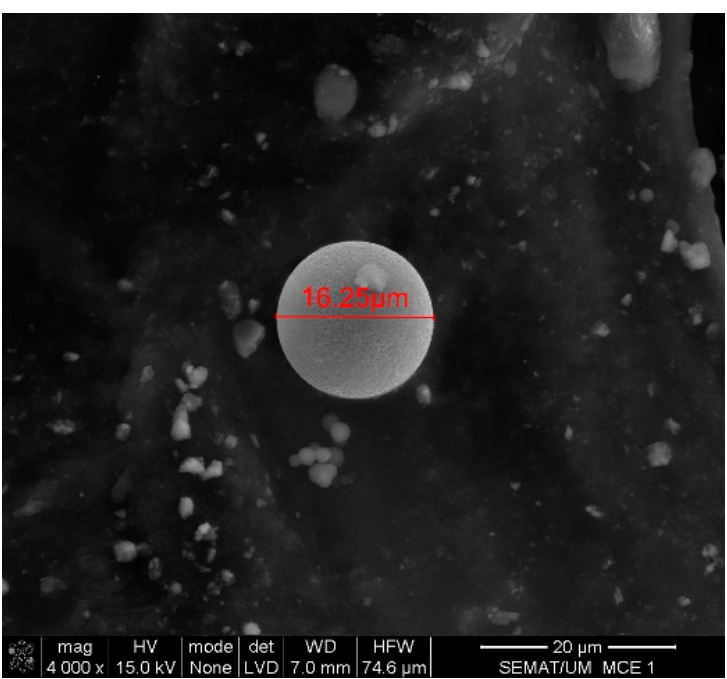
Figure 9. SEM analysis results: Sample collected during Trial 2 with the tungsten carbide–nickel alloy.